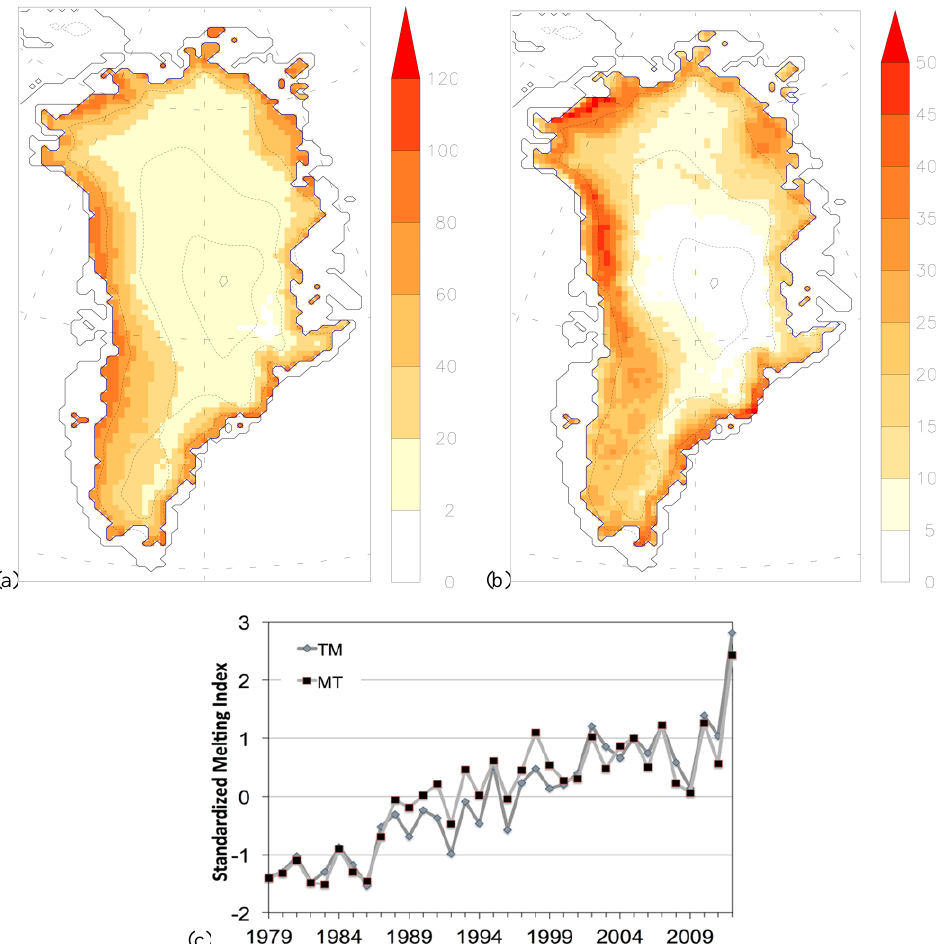
Fig. 4. (a) Melt duration (days) during June, July and August of 2012 from Mote and Anderson (1995) and (b) departure from the 1981–2010 average. (c) Standardized melting index (SMI) for the period 1979–2012 using the algorithm in Mote and Anderson (1995), denoted as TM, and in Tedesco (2009), denoted as MT.